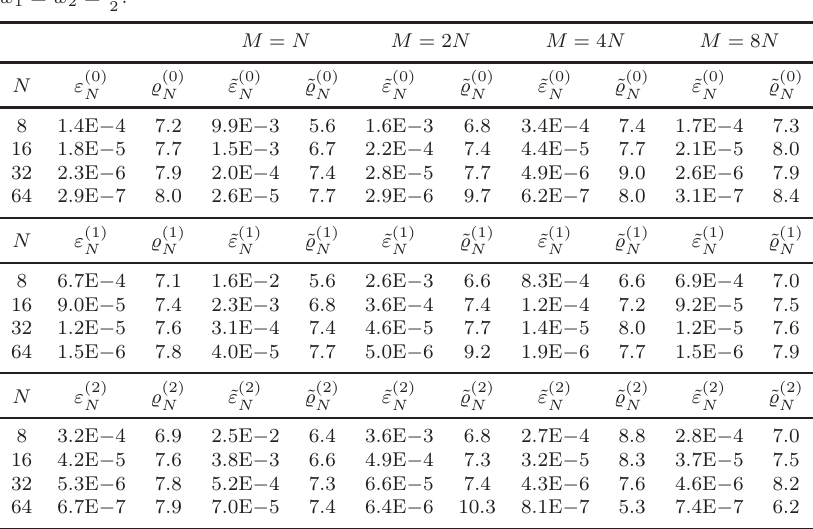
Table 5.1. Results for r = 2 , r w 1 = w 2 = 1